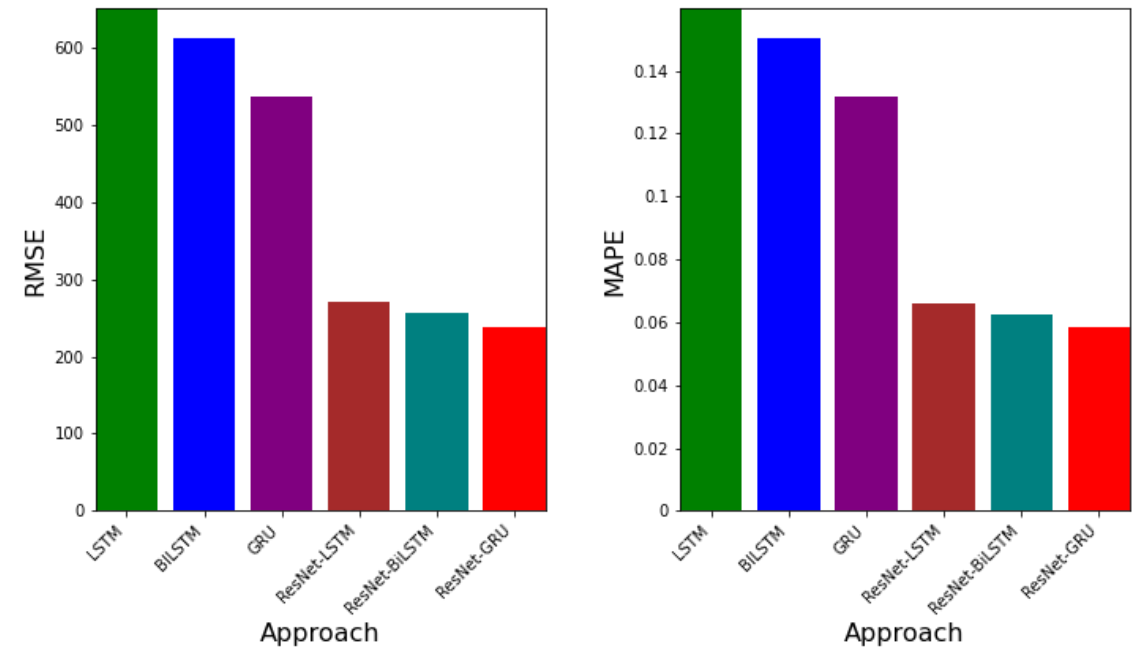
Figure 15. The graph of RMSE and MAPE values for each